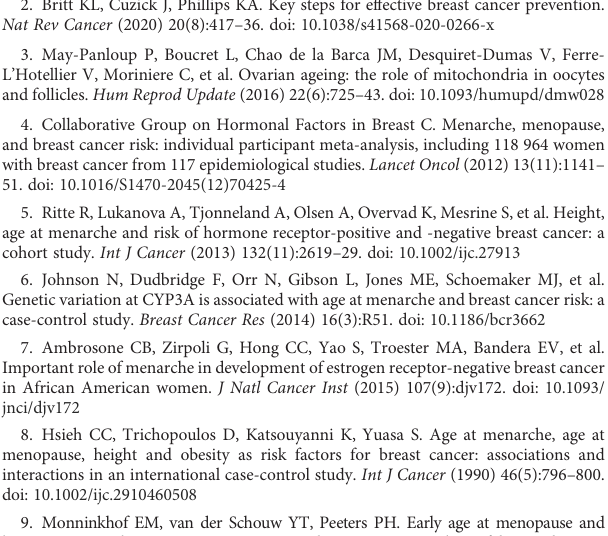
SUPPLEMENTARY FIGURE 7 Analysis of the association between the risk model and chemotherapeutics, endocrine therapy, and targeted therapy in the METABRIC cohort. (A – F) The model predicting the sensitivity to chemosensitivity. It was estimated that low-risk patients had lower IC50 for chemotherapeutics of doxorubicin, etoposide, gemcitabine, paclitaxel, vinorelbine and 5- fl uorouracil. (GH) The model predicting the sensitivity to endocrine therapy. It was estimated that low-risk patients had lower IC50 of tamoxifen and fulvestrant. (I – M) The model predicting the sensitivity to targeted therapy. It was estimated that low-risk patients had lower IC50 of lapatinib, sunitinib, dasatinib, pazopanib and ruxolitinib. SUPPLEMENTARY FIGURE 8 Analysis of the association between the risk model and chemotherapeutics, endocrine therapy, and targeted therapy in the GSE86166 cohort. (A – E) The model predicting the sensitivity to chemosensitivity. It was estimated that low-risk patients had lower IC50 for chemotherapeutics of doxorubicin, etoposide, gemcitabine, paclitaxel and 5- fl uorouracil. (FG) The model predicting the sensitivity to endocrine therapy. It was estimated that low- risk patients had lower IC50 of tamoxifen and fulvestrant. (H – K) The model predicting the sensitivity to targeted therapy. It was estimated that low-risk patients had lower IC50 of lapatinib, sunitinib, dasatinib and